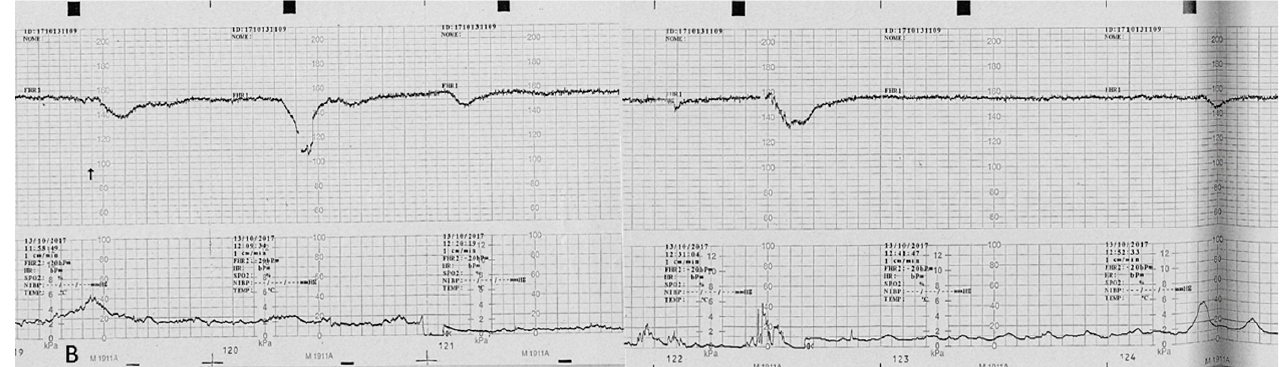
Figure 4. Computerized electronic fetal monitoring (EFM) during antepartum showing absent long- term variability (<5 bpm) associated with recurrent shallow late deceleration (Class III American College of Obstetricians and Gynecologists